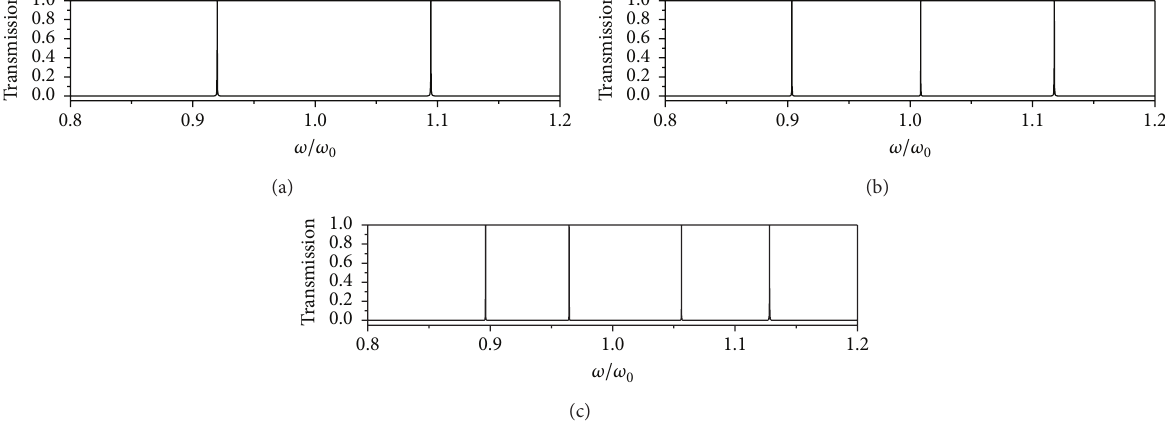
6 (𝐴𝐵) 6 the 1D PCs (𝐵𝐴) ; that is, the quantum transmission peaks are gained and attenuated when the medium 𝐵 is active medium (𝑛 𝑏 = 2 . 45 − 𝑖 0 . 0001 ) and absorbing medium